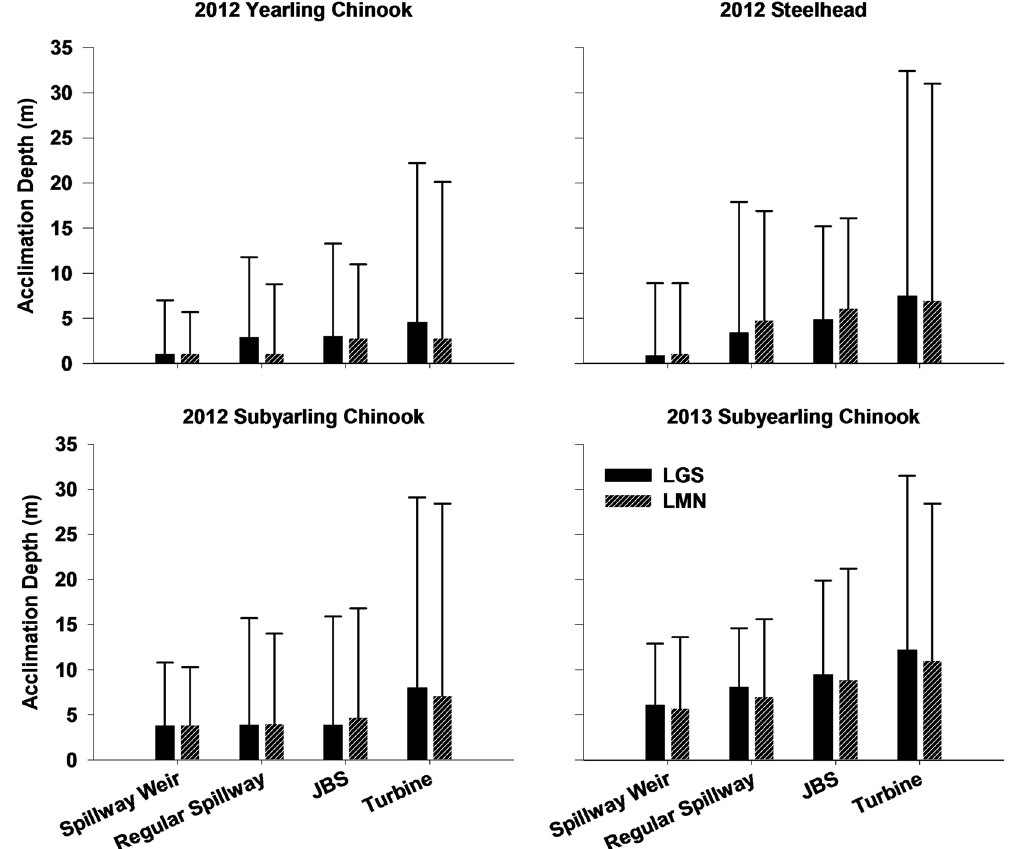
Figure 2. Median acclimation depth (edge of solid bar) and most common (95%) acclimation depth (edge of whisker) of acoustic tagged juvenile fish that passed through the four different routes at LGS and LMN in 2012 and